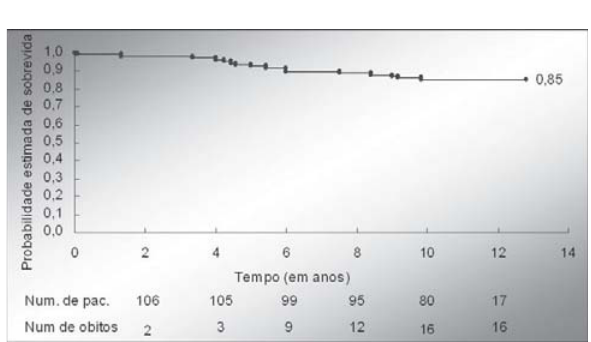
Fig. 5 – Probabilidade estimada livre de